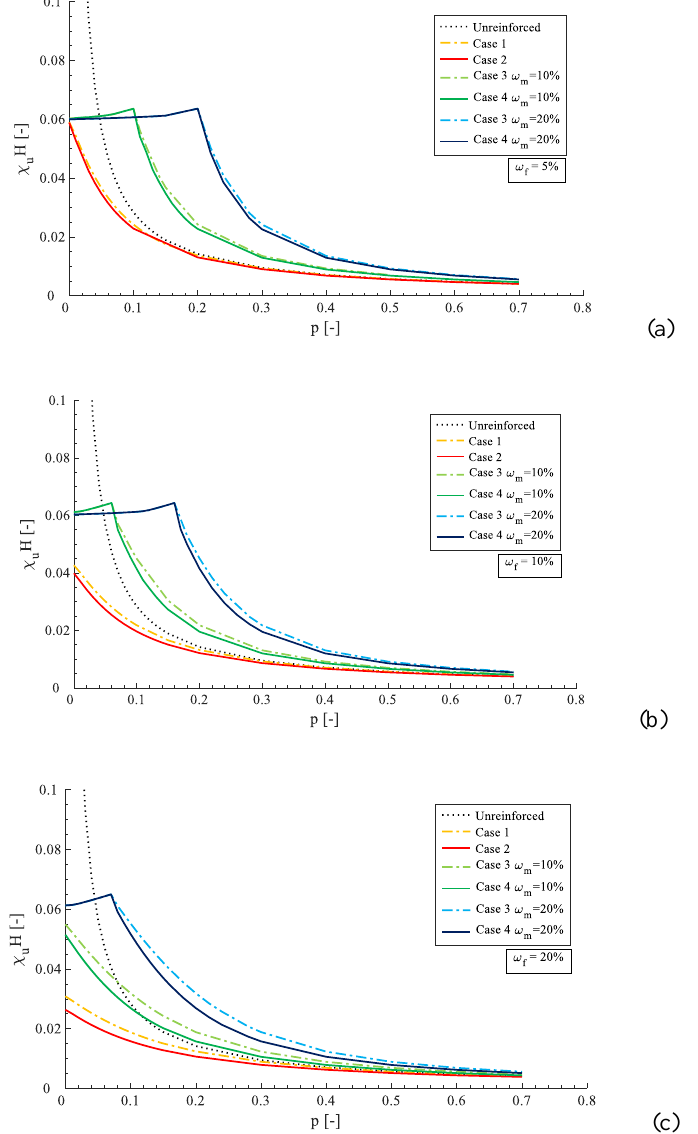
Figure 9. Axial load-ultimate curvature diagrams for all 4 cases: ( a ) ω f is fixed (5%); ( b ) ω f is fixed (10%); ( c ) ω f is fixed (20%).